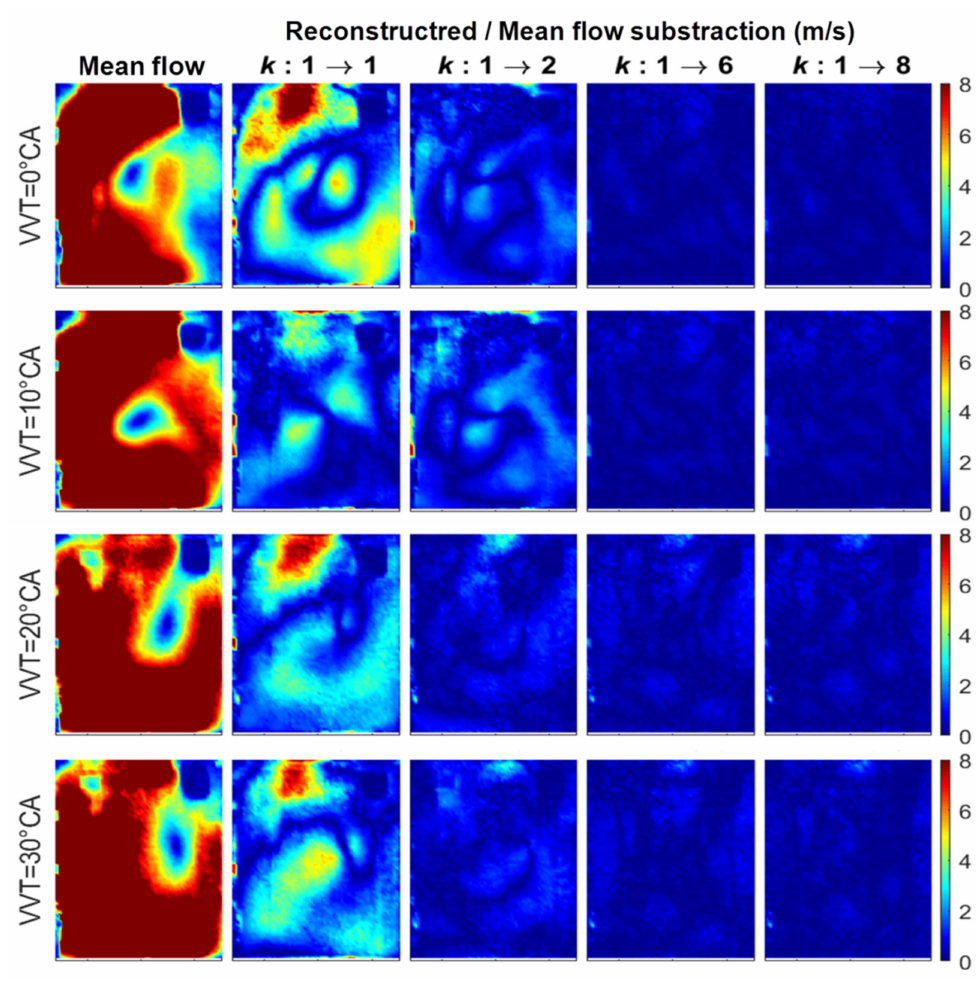
Figure 8. Reconstructed and mean flow subtraction; θ = 130 ◦